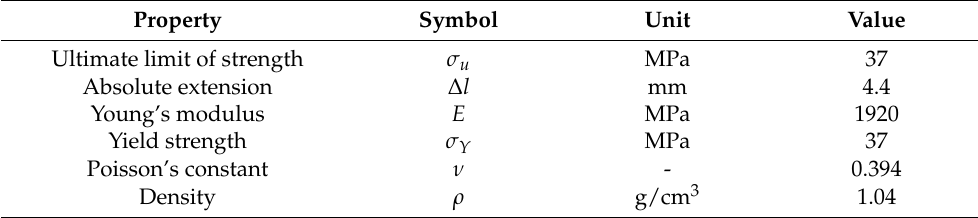
Table 1. Properties of ABSplus-P430 Ivory material